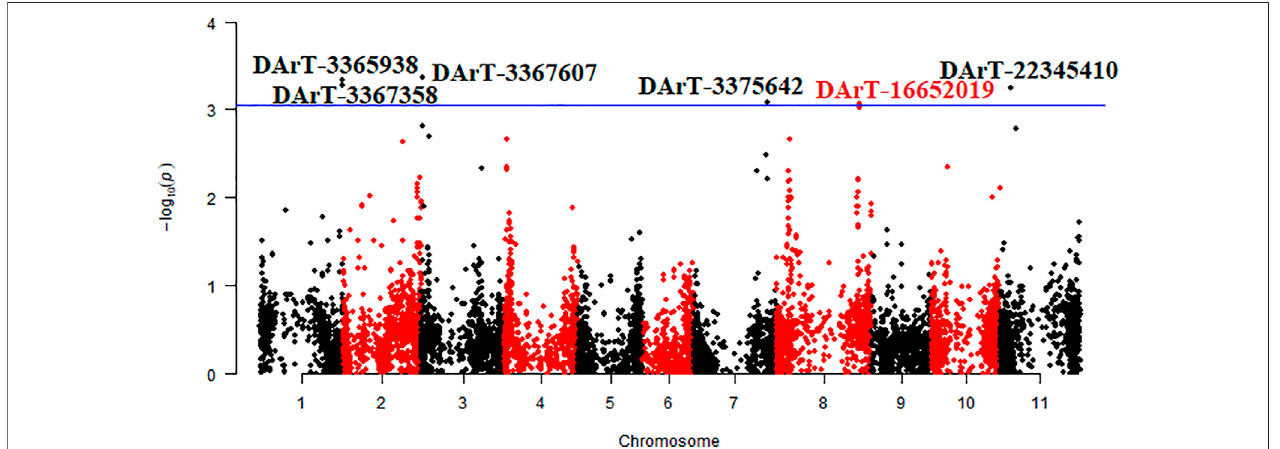
FIGURE 4 | Manhattan plot of marker trait association for magnesium content in Turkish common bean germplasm.